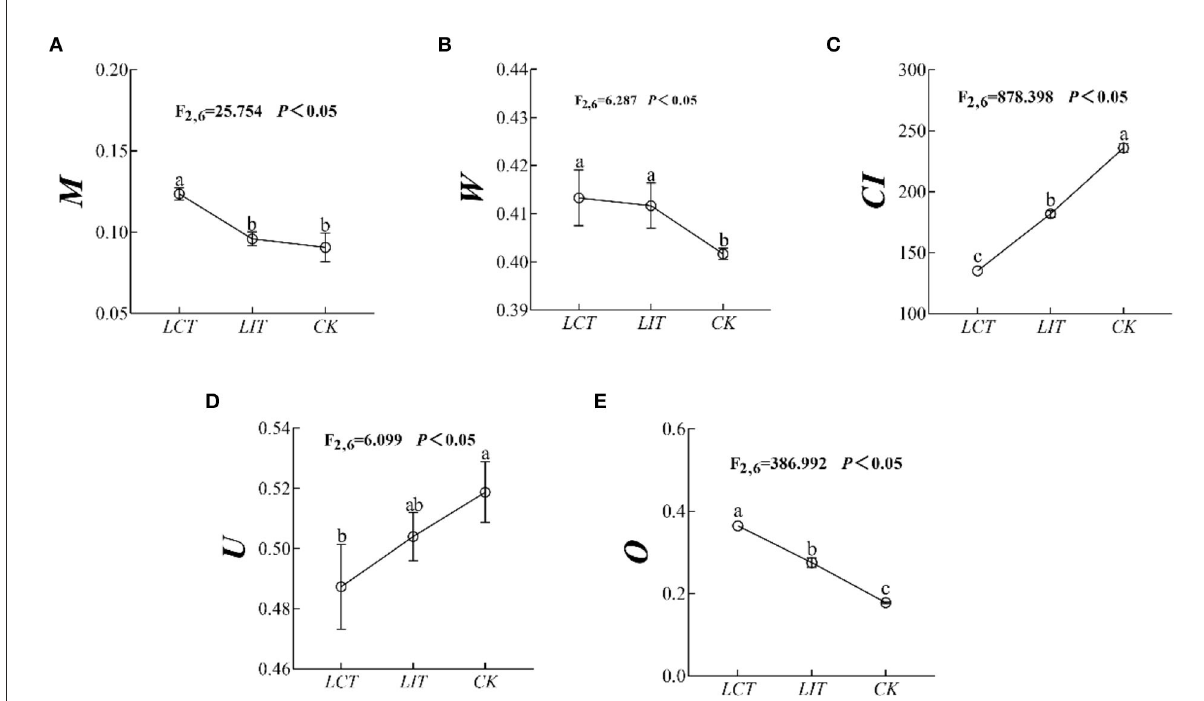
FIGURE2 The forest stand spatial structure characteristic index. The logging methods are LCT , logging of the competitive trees; LIT , logging of the inferior trees; CK , unlogged control. The stand spatial structure parameters are M , mingling index; W , uniform angle index; CI , competition index; U , neighborhood comparison; and O , opening degree. Data shown are the mean ± standard deviation ( n = 3). Different lowercase letters indicated significant differences among the treatments ( p < 0.05) in (A–E)